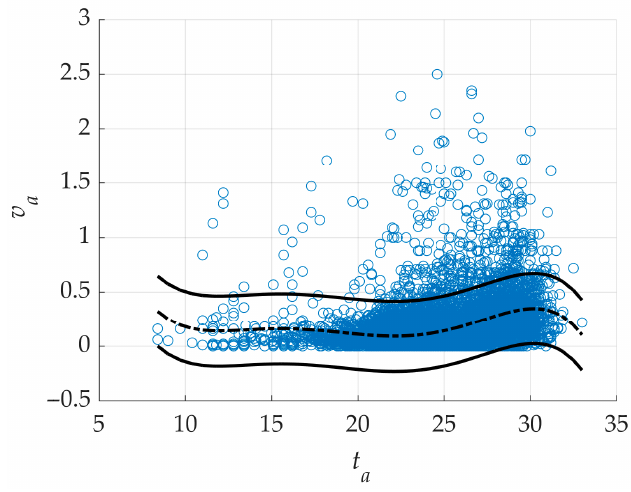
Figure 4. Envelope curves for air-velocity adjustable raw sample points. (The middle dashed line is the fitting curve of data, the upper and lower two lines of the three curves represent the enve- lope curve).